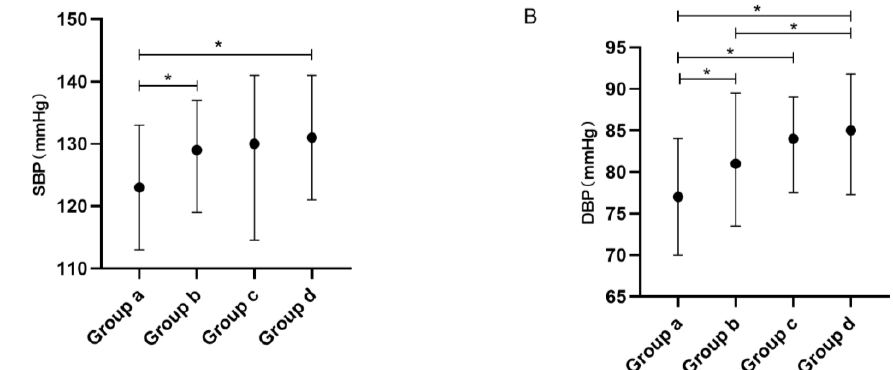
Figure 2. Blood pressure levels stratified by obesity and severe OSA. Footnote: Group a, non-obese obese subjects with severe OSA and the obese subjects with severe OSA, and a signifi- with non-severe OSA group; Group b, non-obese with severe OSA group; Group c, obese with cantly lower percentage of hypertension than the other three groups (all p < 0.05; see Table non-severe OSA group; Group d, obese with severe OSA group; subfigure A, comparison of SBP 3 and Figure 4). level among the four gruops; subfigure B, comparison of DBP level among the four groups; *, p < 0.05. Abbreviations: OSA, obstructive sleep apnea; SBP, systolic blood pressure; DBP, diastolic Table 3. Percentages of abnormal blood pressure stratified by obesity and severe OSA. blood pressure.